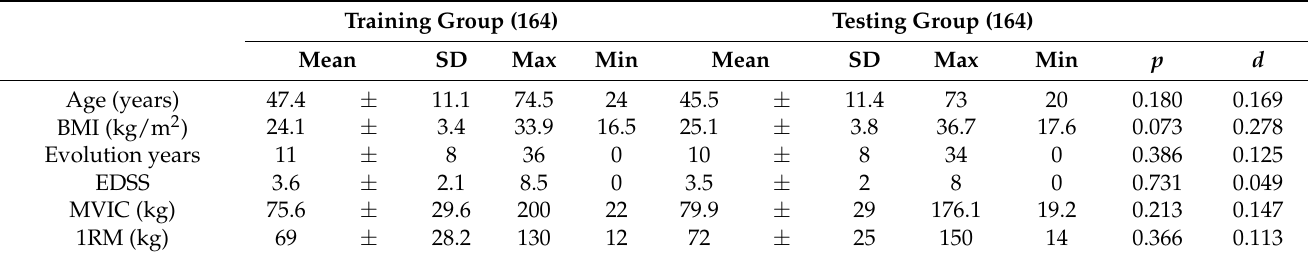
Table 4. Variables of the sample separated by training group and testing group.